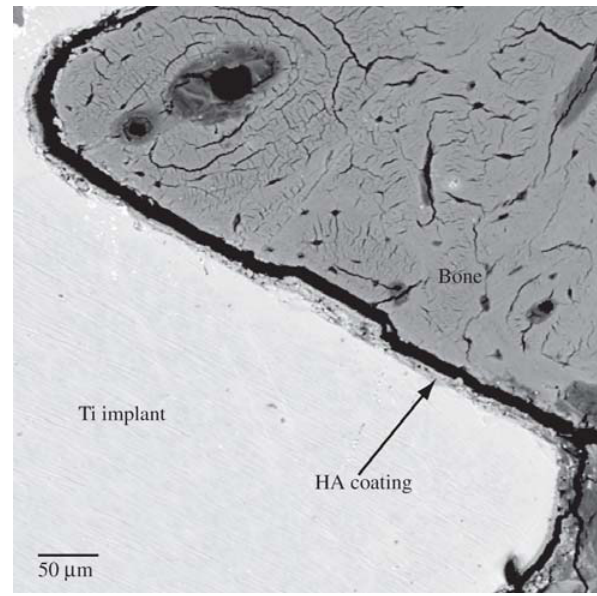
Figure 2. BSE image of the bone-implant interface after in vivo test; (100